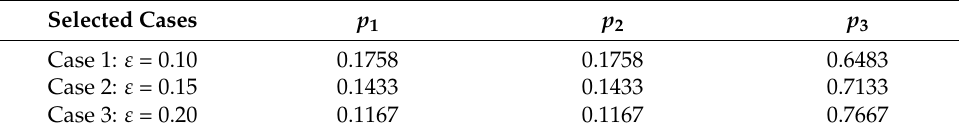
Table 1. Probability distributions included in the simulation study for k = 3.